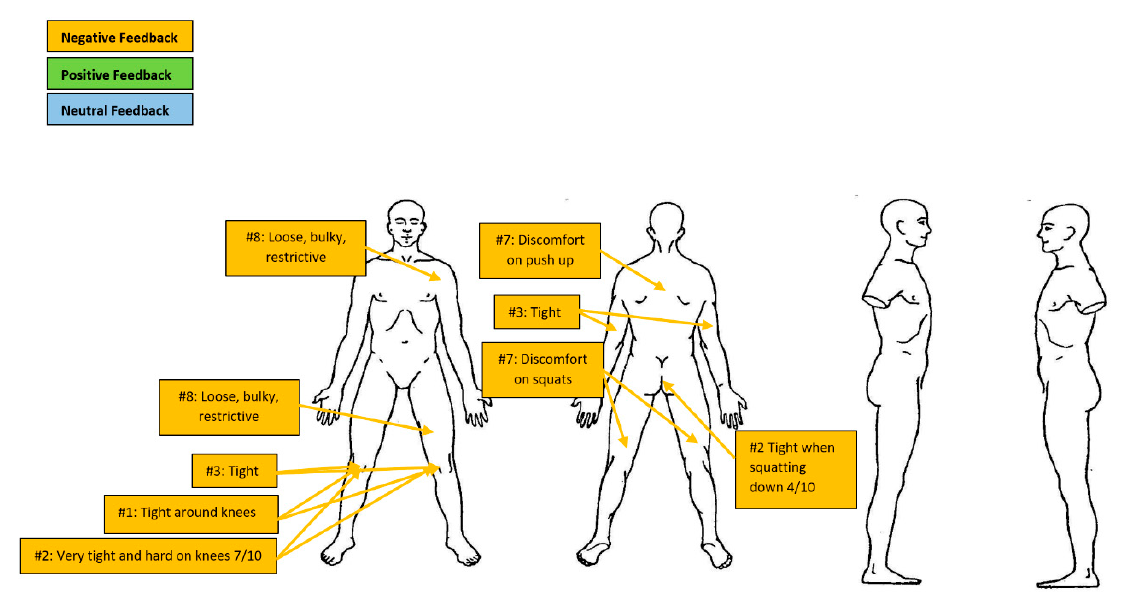
Figure 15. Subjective feedback (n = 5) on station wear with Variant 2 (SV2) (# signifies participant number; scores out of 10 signify discomfort level).